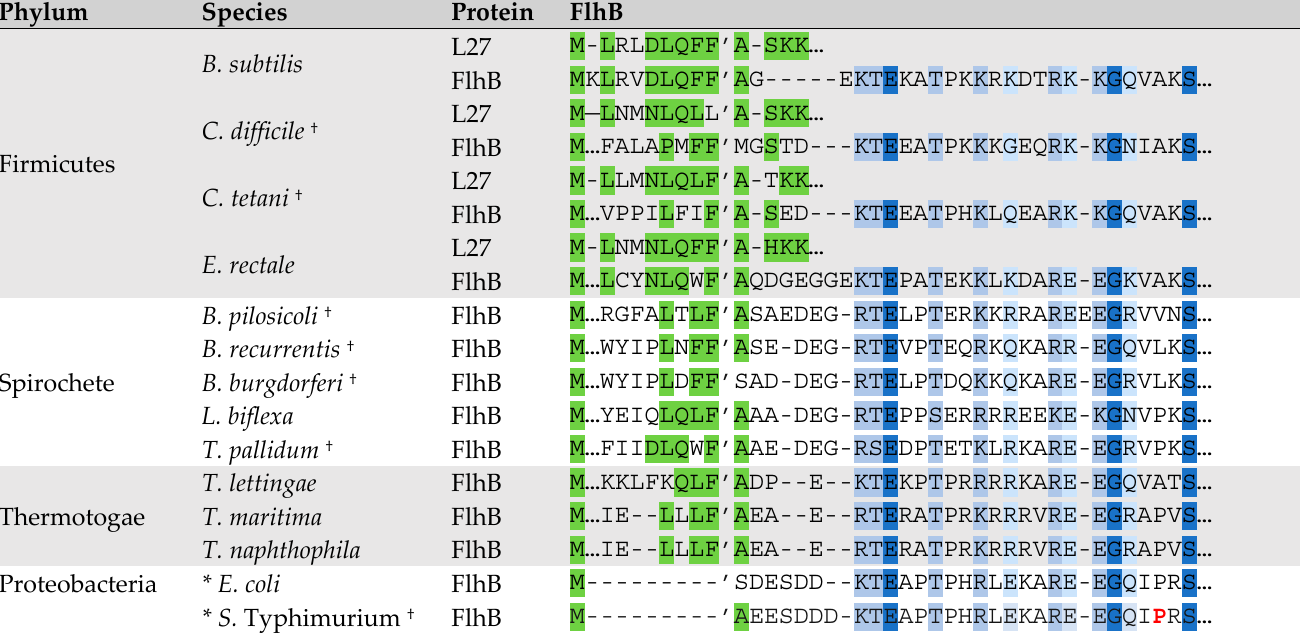
Table 3. FlhB and L27 N-terminal extension cleavage sequence